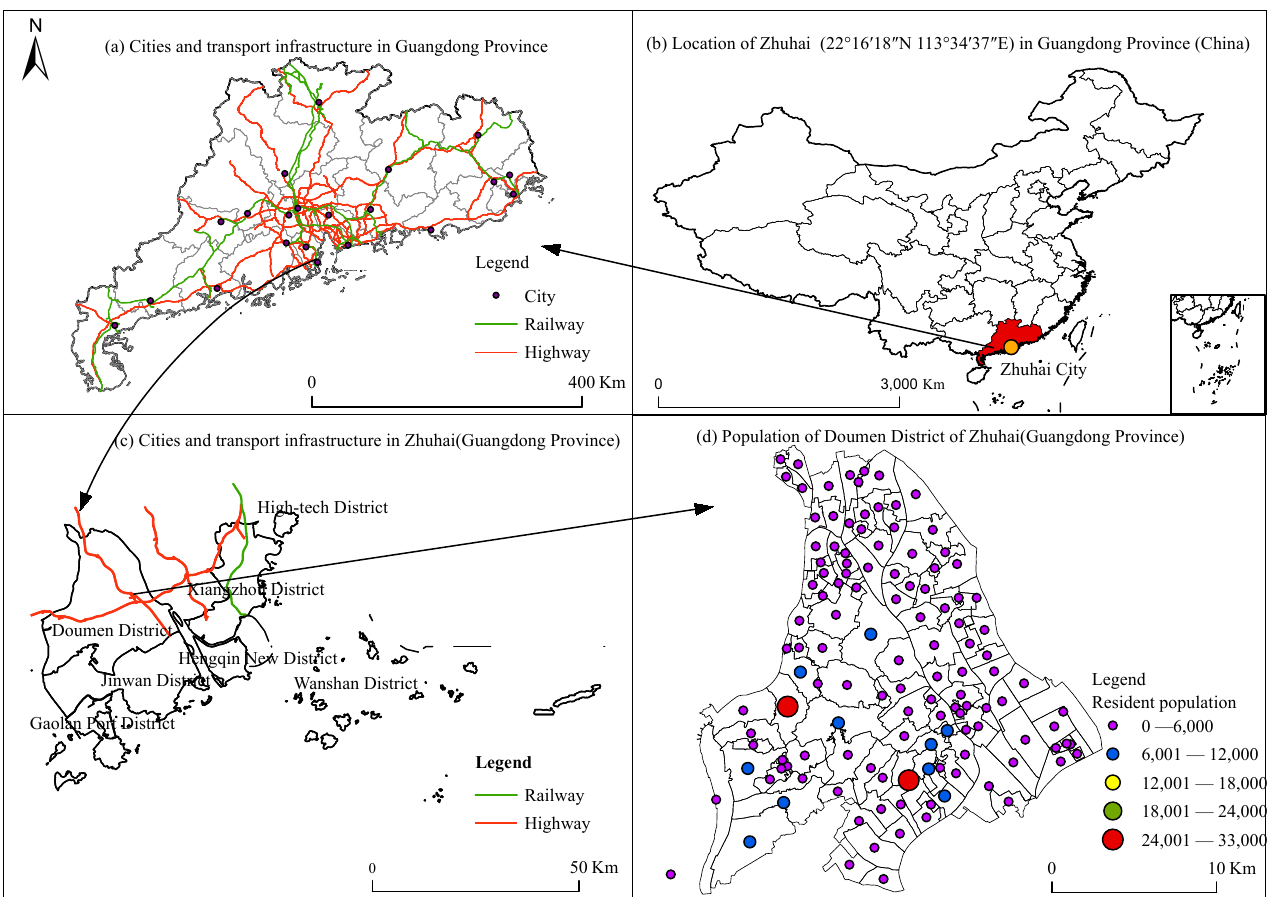
Figure 1. The geographic distribution of the study area. ( a ) Cities and transport infrastructure in Guangdong Province. ( b ) Location of Zhuhai in Guangdong Province (China). ( c ) Cities and transport infrastructure in Zhuhai (Guangdong Province). ( d ) Population of Doumen District of Zhuhai (Guangdong